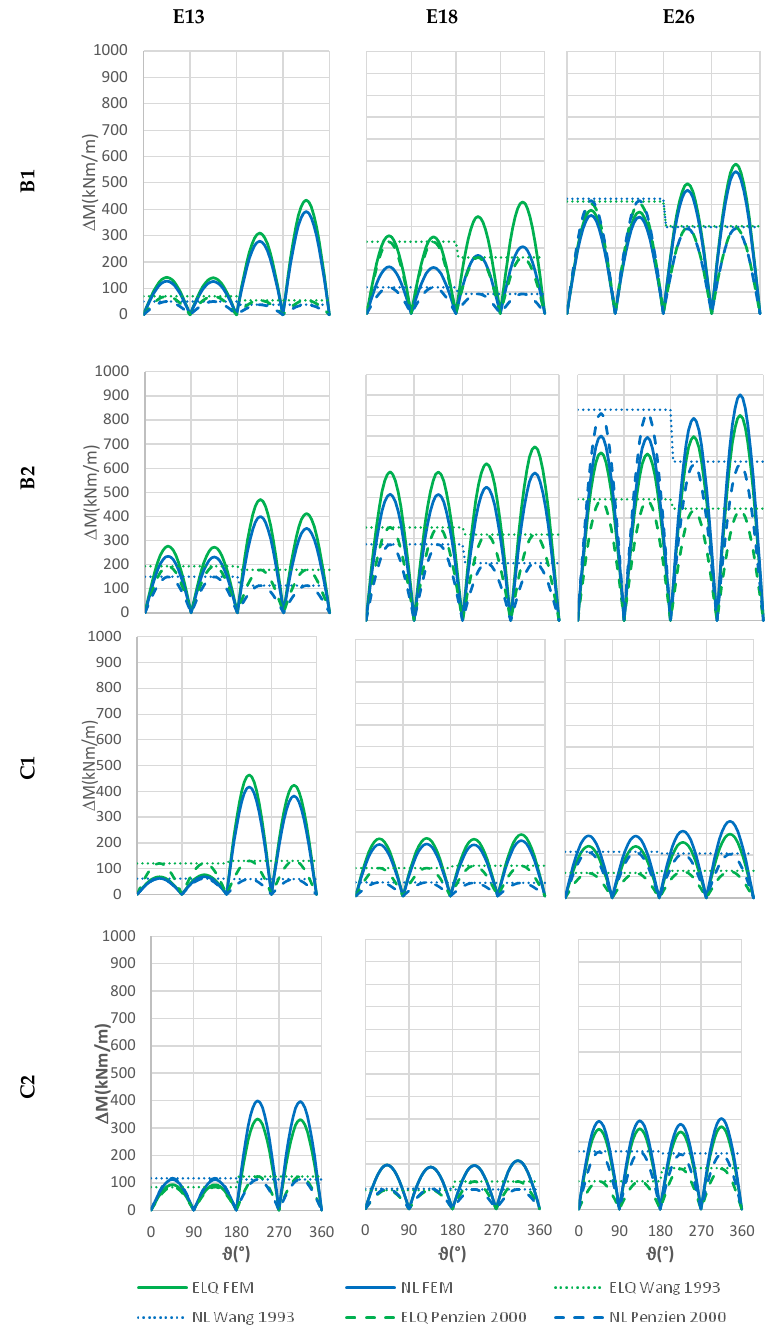
Figure 22. Comparison between analytical and numerical bending moments obtained by the two different constitutive models (ELQ vs. NL).